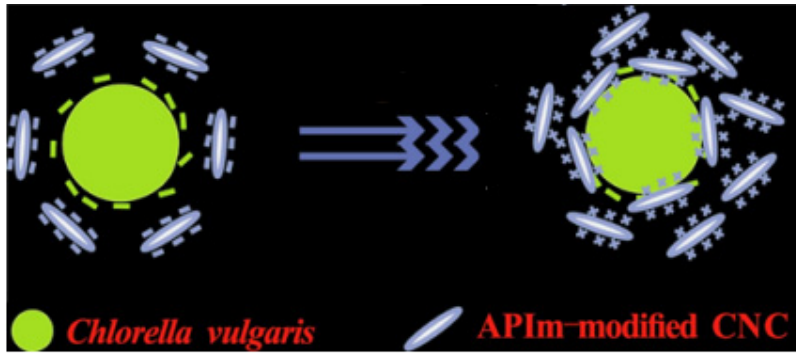
Figure 8. Illustration on the electrostatic attraction between Chlorella vulgaris and APIm-modified CNC. This figure was adapted from [120].